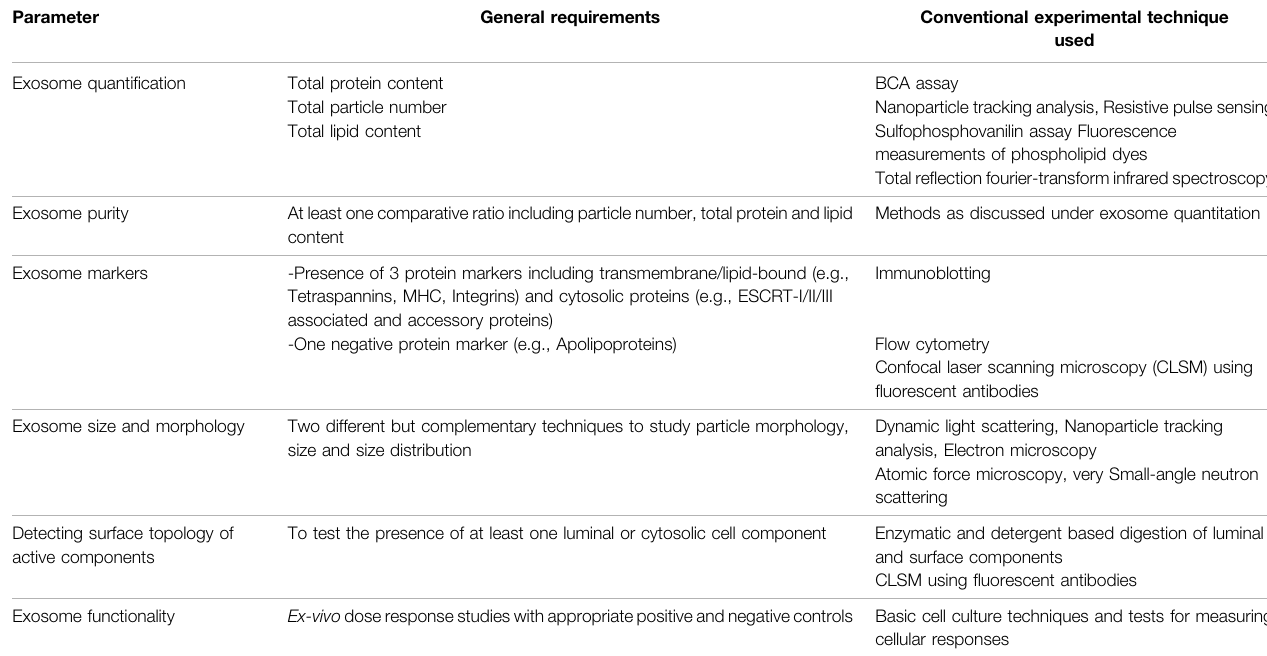
TABLE 1 | General parameters and methods for characterizing exosomes (Witwer et al., 2013; Thery et al., 2018).